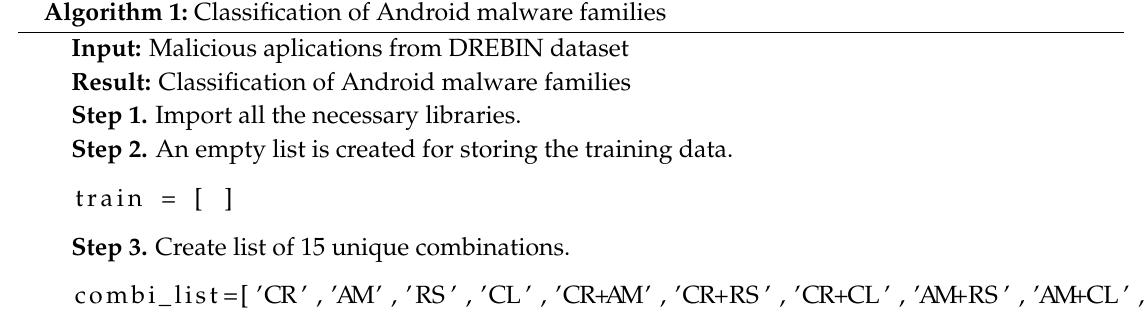
Algorithm 1: Classification of Android malware